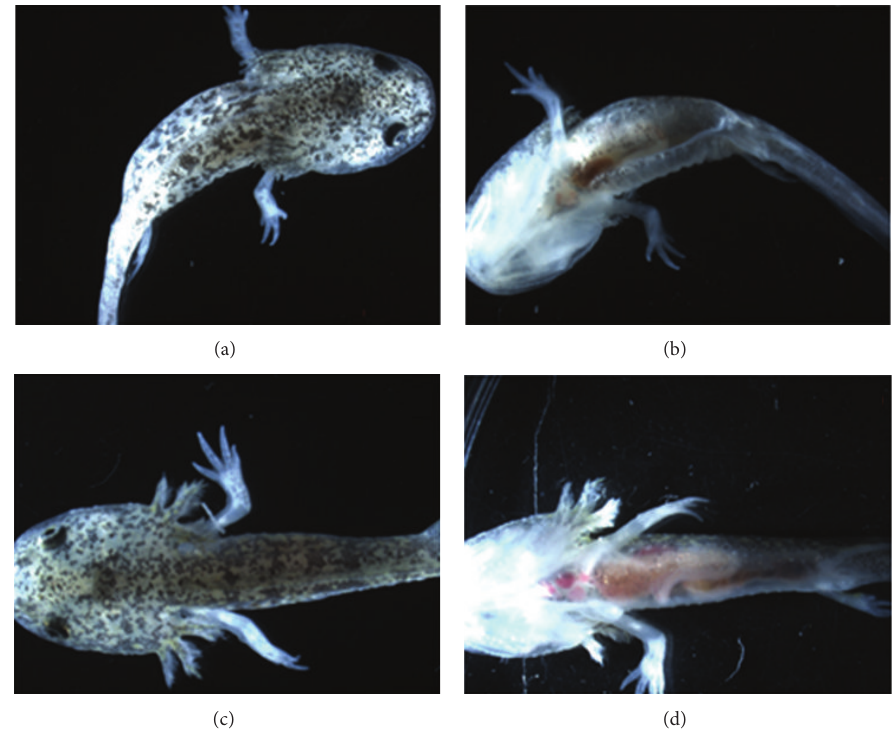
Figure 1: Dorsal and ventral views of axolotl larva with abdominal distension ((a) and (b)). Dorsal and ventral views of a normal axolotl larva ((c) and (d)). Note the presence of abdominal fluid in the larva with the distension